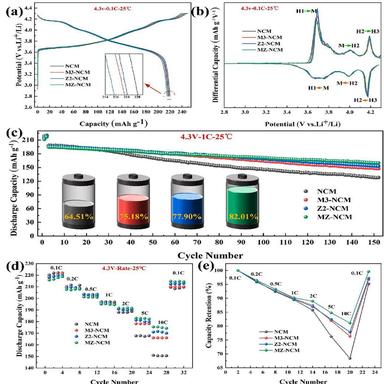
Electrochemical performance comparison of NCM, M3-NCM, Z2-NCM and MZ-NCM. (a) Initial charge/discharge specific capacity curves and (b) the corresponding differential capacitance profiles. (c) Cycling performance, (d) rate properties and (e) corresponding capacity retention.